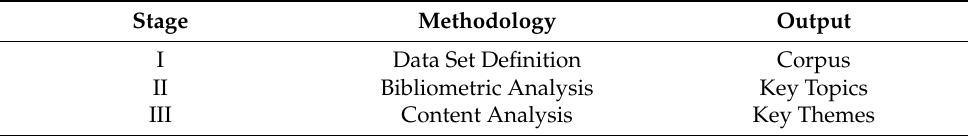
Table 1. Research design. Stage